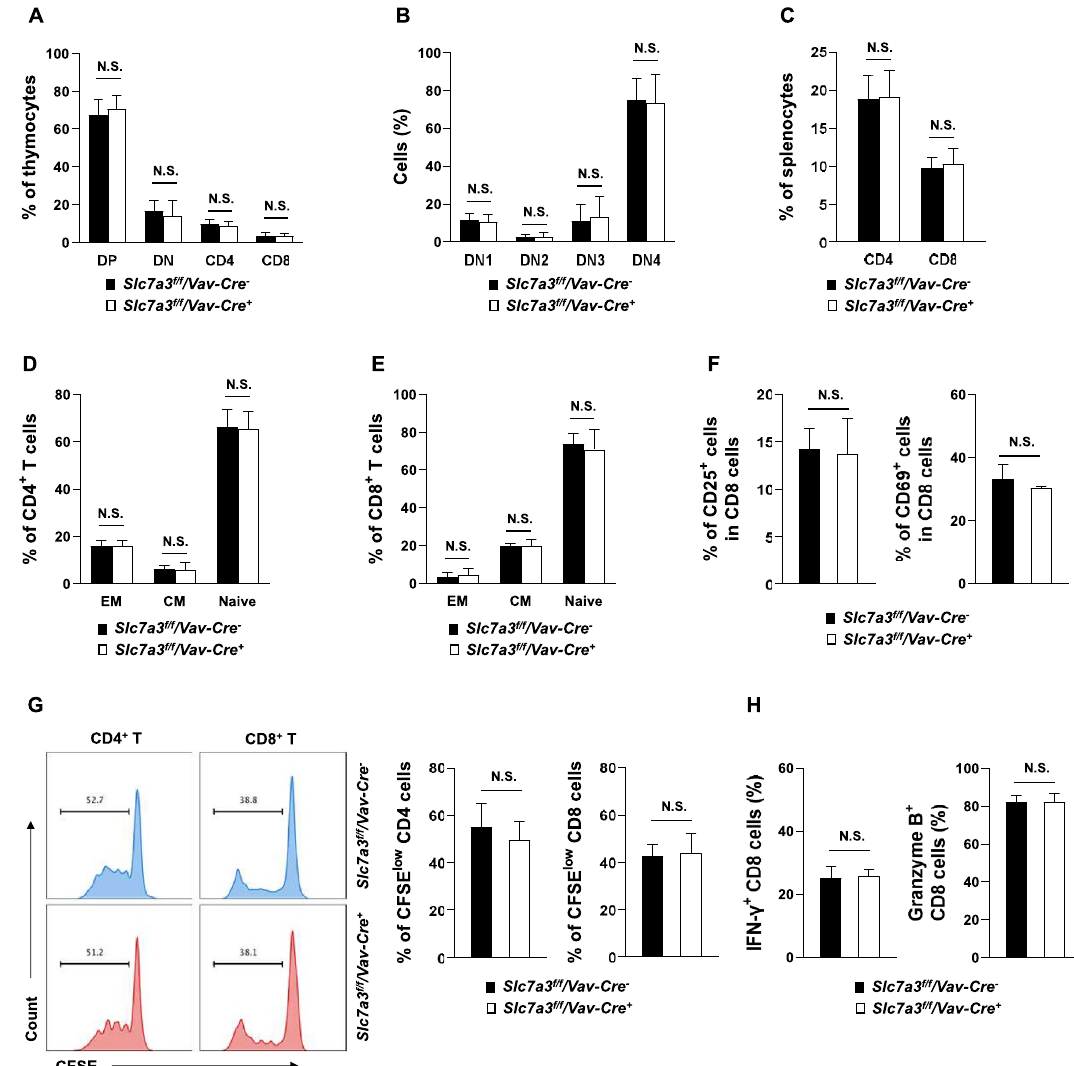
Figure 3. T cell development, activation, and proliferation are not disturbed by the deletion of Slc7a3 . ( A , B ) Thymocytes freshly isolated from 8-week-old Slc7a3 f/f /Vav1-Cre + mice and Slc7a3 f/f /Vav1-Cre − littermates were stained with the indicated antibodies. Percentages of CD4 and CD8 double-negative (DN) cells, double-positive (DP), and CD4 and CD8 single-positive cells were quantified (n = 6 mice/genotype) ( A ). DN1 (CD44 + CD25 − ), DN2 (CD44 + CD25 + ), DN3 (CD44 − CD25 + ), and DN4 (CD44 − CD25 − ) cells in the DN population were further determined (n = 6 mice/genotype) ( B ). ( C - E ) Splenocytes freshly isolated from 8-week-old Slc7a3 f/f /Vav1-Cre + mice and Slc7a3 f/f /Vav1-Cre − littermates (n = 5 mice/genotype) were processed for FACS analyses. Frequencies of CD4 + and CD8 + T cells in the spleen were quantified ( C ). Percentages of T cells in various functional status (Effector memory T cells: CD44 + CD62L − ; Central memory T cells: CD44 + CD62L + ; Naïve T cells: CD44 − CD62L + ) in CD4 + ( D ) and CD8 + ( E ) populations were quantified. ( F - H ) CD8 T cells isolated from the spleen of Slc7a3 f/f /Vav1-Cre + and Slc7a3 f/f /Vav1-Cre − mice were labeled by carboxyfluorescein succinimidyl ester (CFSE) and stimulated with T cell activator anti-CD3/CD28 Dynabeads. Percentages of CD8 T cells expressing CD25 or CD69 were quantified by FACS 24 h after the stimulation (n = 5 mice/genotype) ( F ). Four days after anti-CD3/CD28 antibody stimulation, CFSE intensities in CD4 and CD8 T cells were assessed by FACS (n = 5 mice/genotype) ( G ). These cells were further stimulated with phorbol 12-myristate 13-acetate (PMA) (80 nM) in the presence of Golgistop (5 µg/ml) for 5 h. IFN-γ + and granzyme B + effector cells were determined by intracellular immunostaining followed by FACS analyses. Percentages of IFN-γ + and granzyme B + cells in CD8 T cell populations were determined (n = 5 mice/genotype) ( H